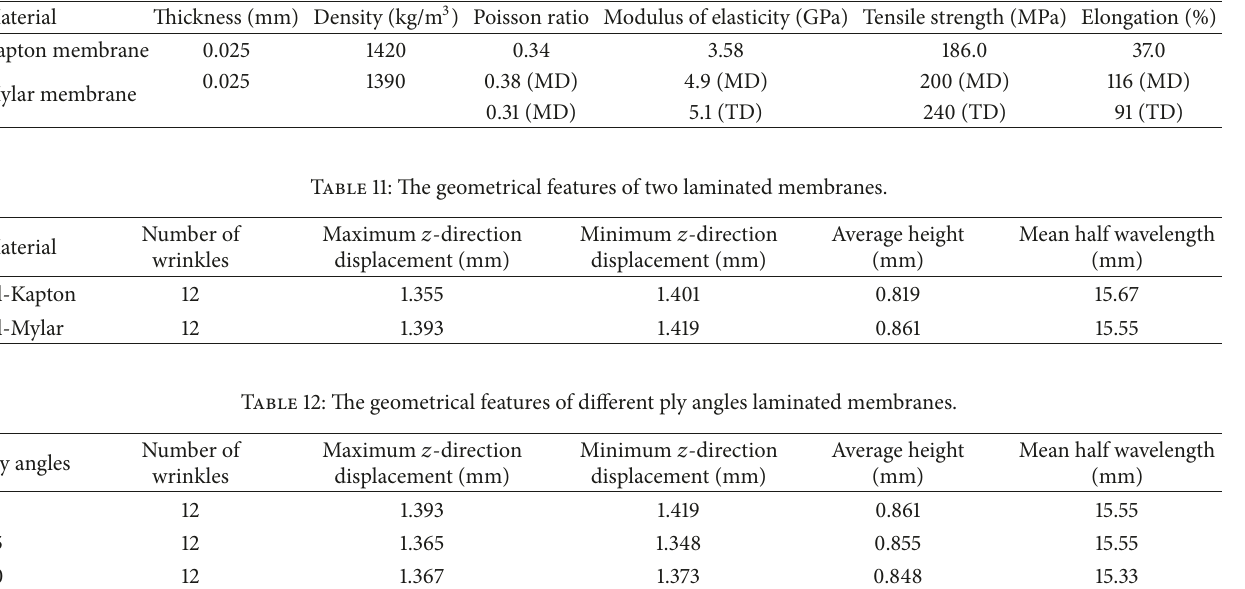
Table 10: Mechanical properties of Kapton and Mylar membrane.